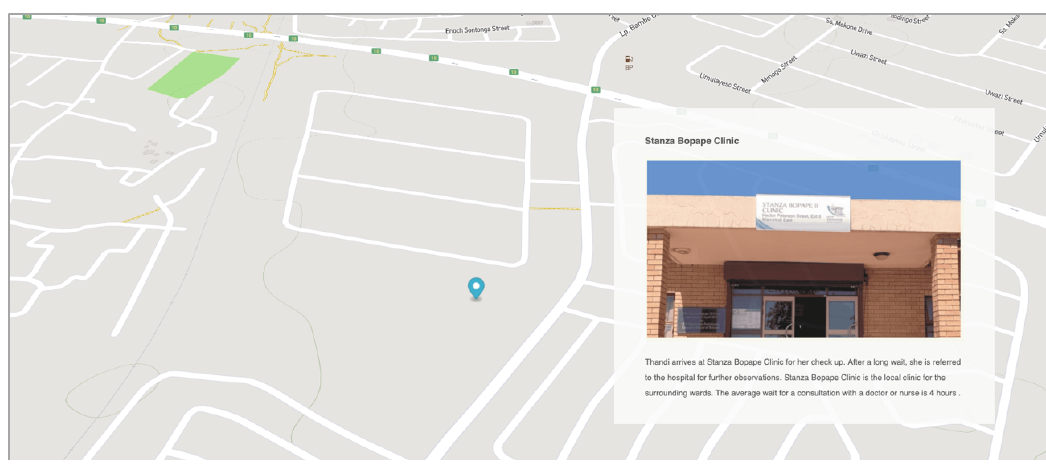
Figure 3. Example of the resulting story map in a) Esri Story Maps and the newer ArcGIS StoryMaps and b)